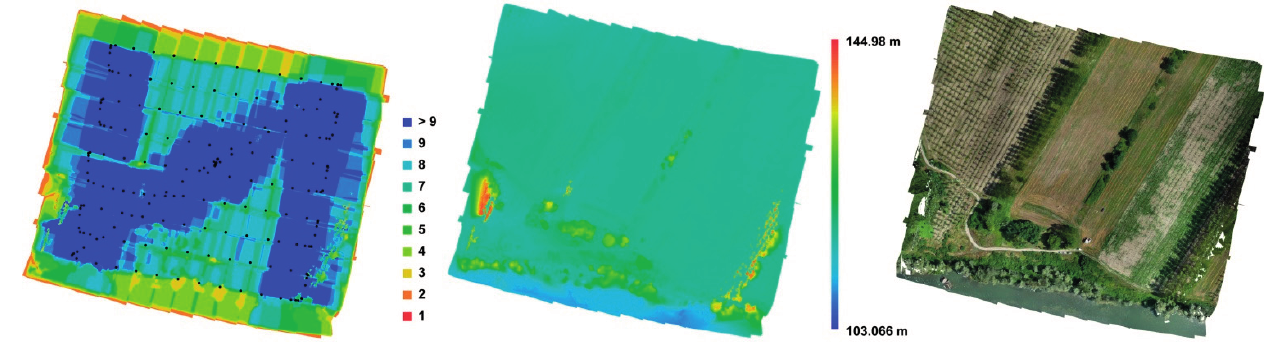
Figure 7. Oriented images with the number of overlaps ( left ), DSM ( center ) and orthoimagery ( right